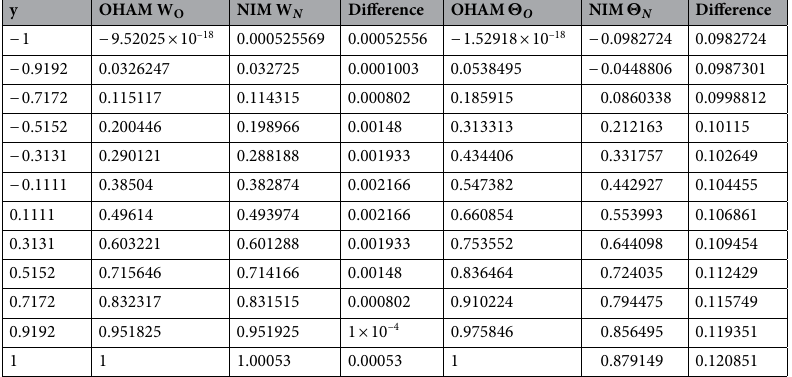
Table 5. For (cid:31) = 0.5, M = 0.0009, B = 0.3 and A = 0.3.